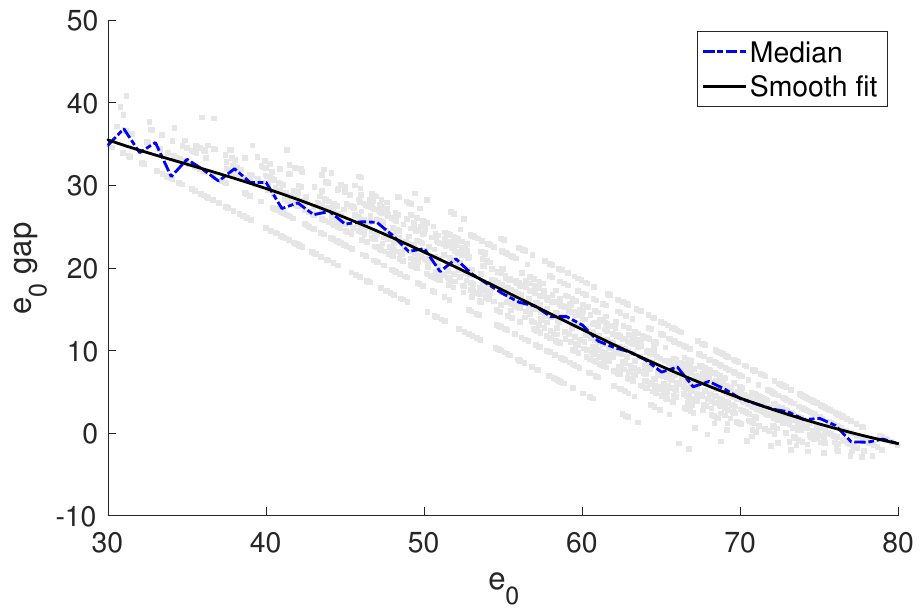
Figure 2. Life expectancy gaps against the life expectancy level for the less developed countries (in grey dots), the 50% quantile (dashed line), and the smoothed fit by the double logistic function (solid